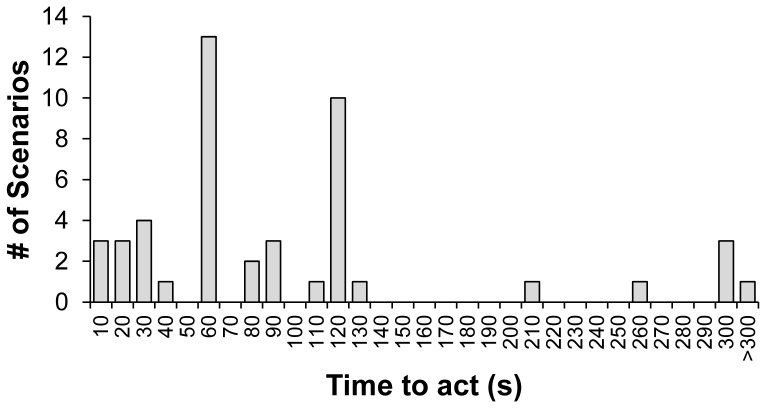
Median rating of number of seconds CHMRs had in which to act for each CHMR scenario.